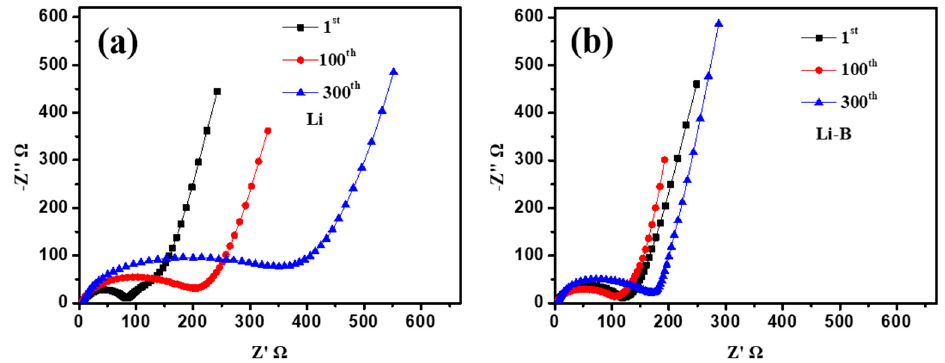
Figure 4. Electrochemical impedance spectra of Li metal ( a ) and Li-B alloy ( b ) after the 1st, 100th, and 300th cycles.